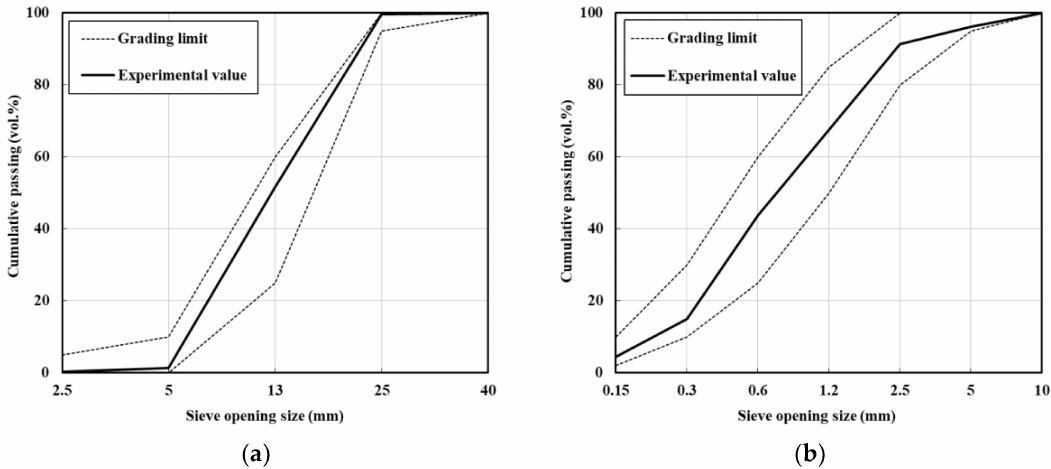
Figure 3. Gradation sieve analyses of the aggregates used: ( a ) coarse aggregate; ( b ) fine aggregate.